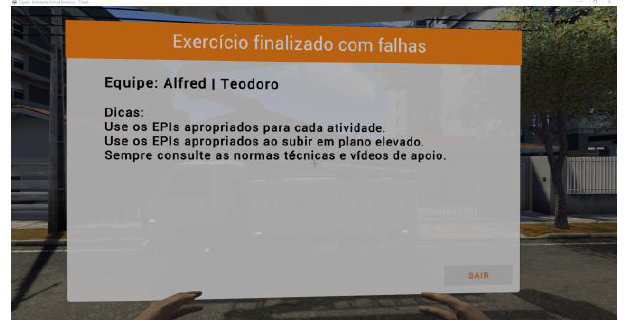
Figure 15. A sample dialog that is shown when the exercise is not successfully